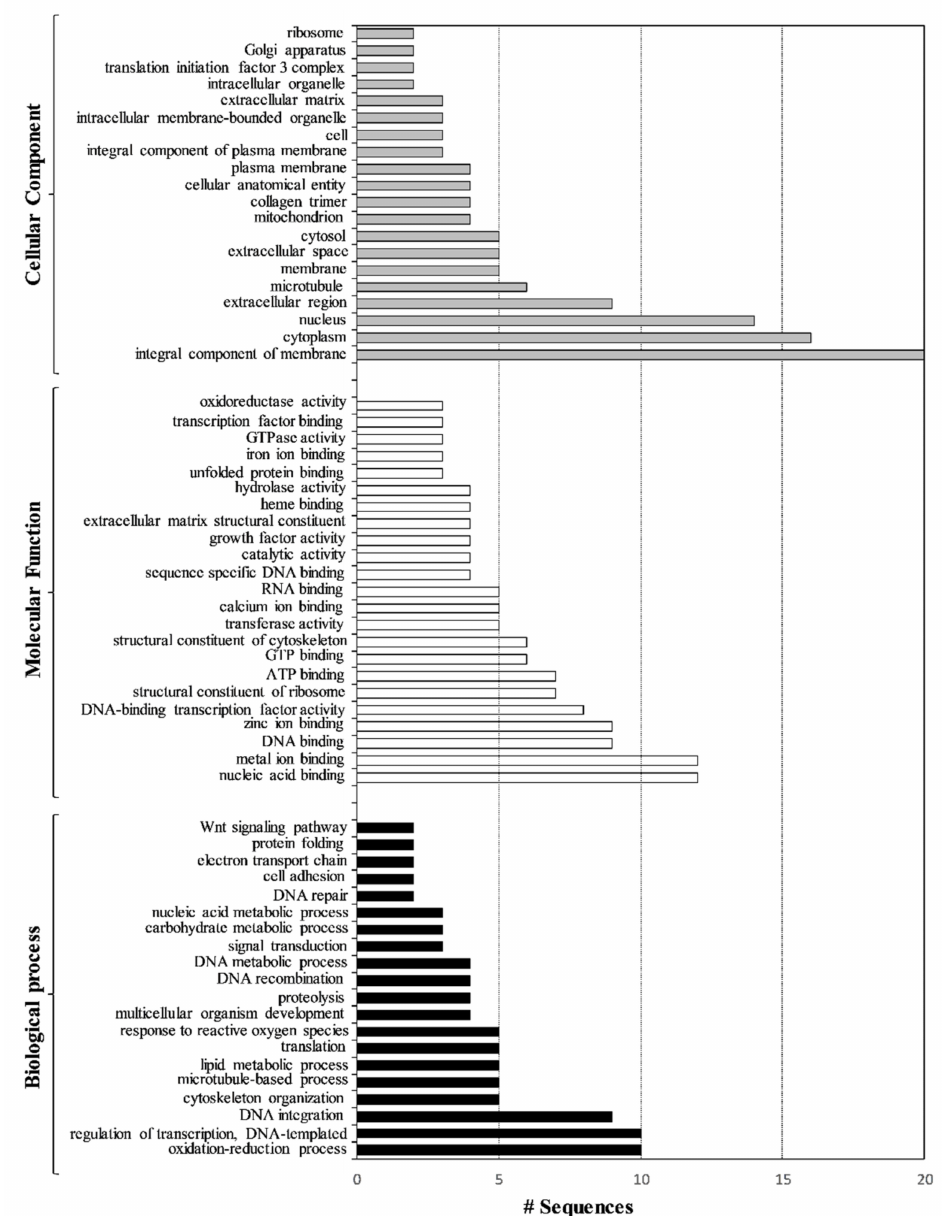
Figure 4. Overrepresented GO terms of sea urchin plutei after artificial contaminated experiments with PAHs and PCBs in the three major functional categories: Biological Process (black bars), Molecular Function (white bars) and Cellular Component (grey bars), which include all the differentially expressed genes (both up- and